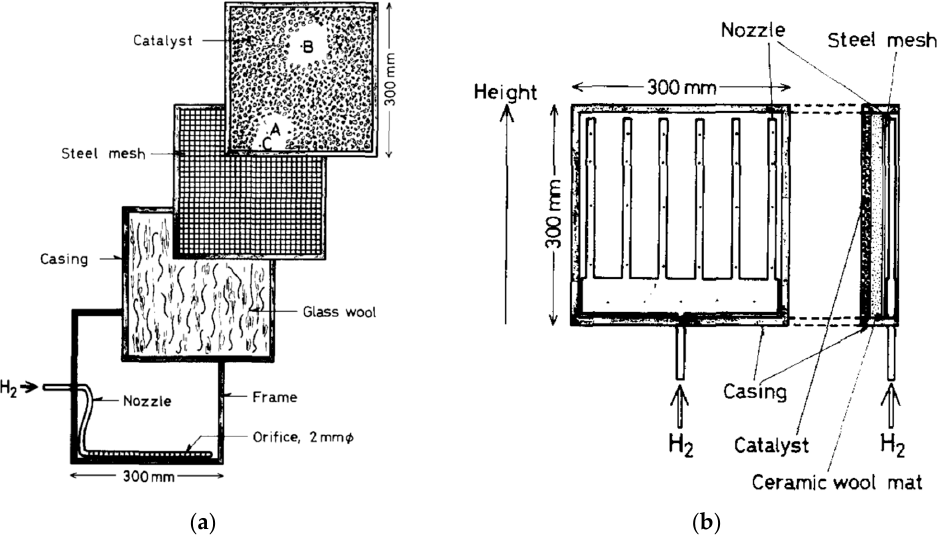
Figure 14. Schematic construction of catalytic burners with a bottom hydrogen distributor ( a ) and a uniform hydrogen distributor ( b ) (reproduced from [146] with permission from Elsevier).